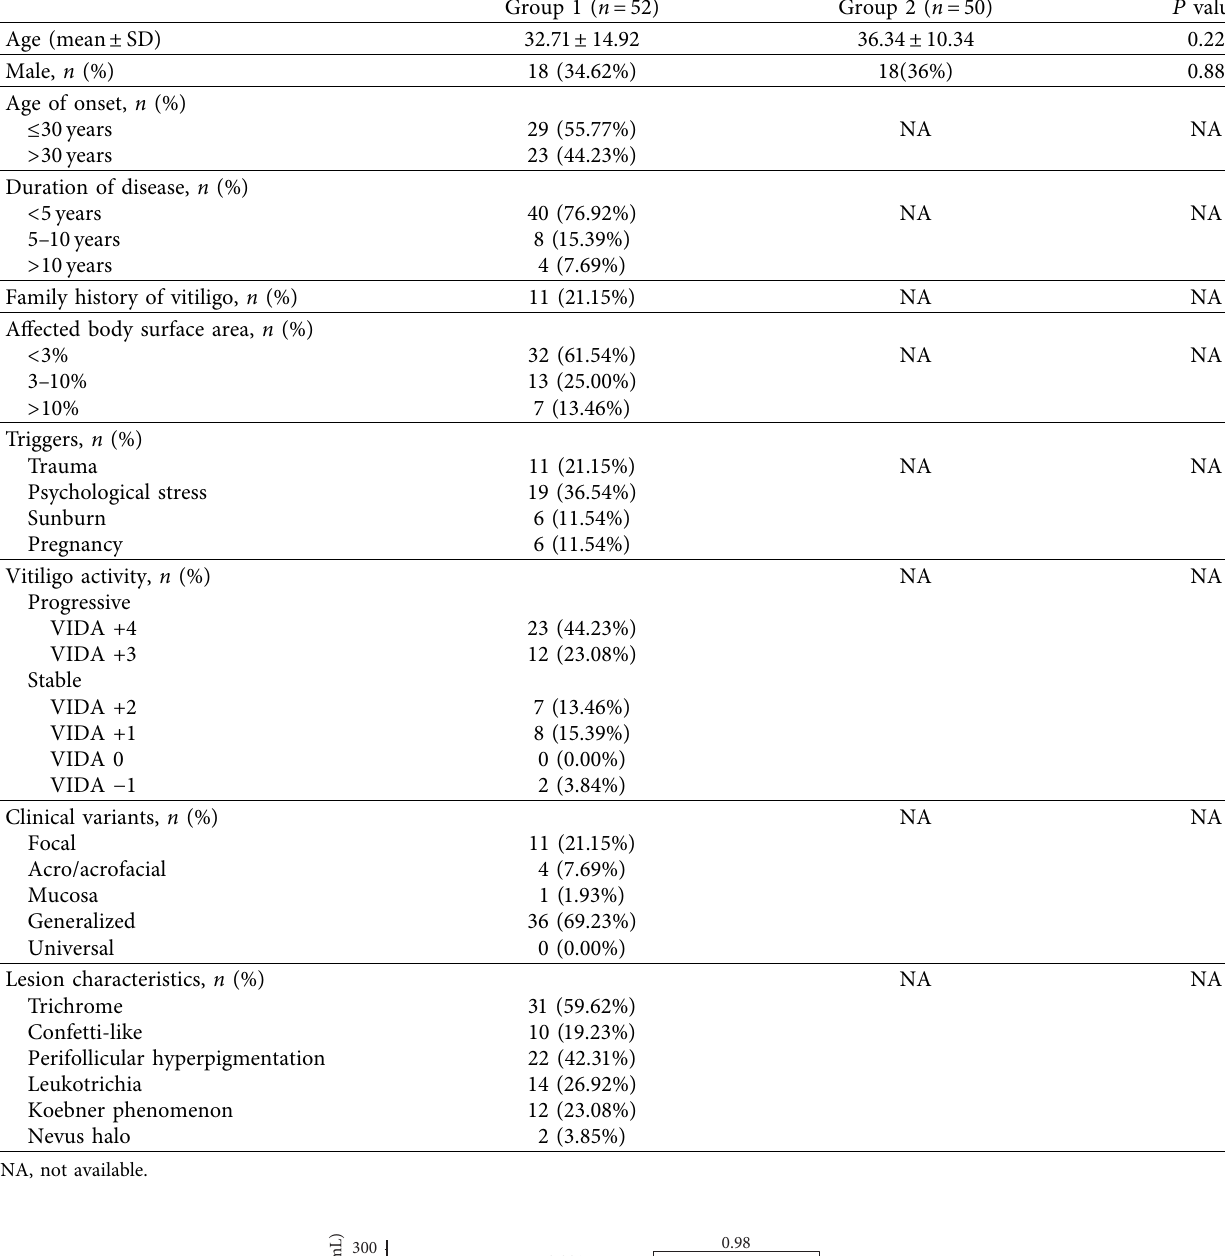
Table 1: Clinical characteristics of study subjects.